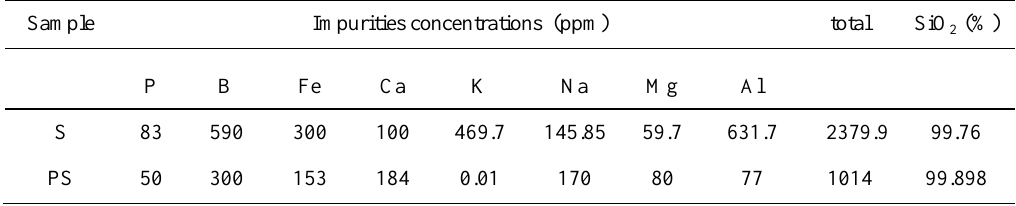
Table 1. Concentrations (ppm) of impurities present in the silica before and after